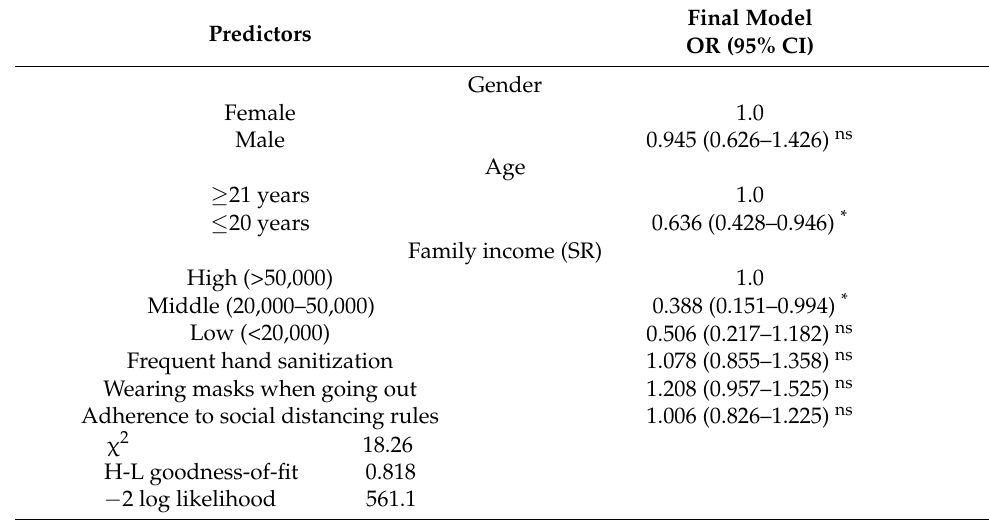
Table 3. Logistic regression analysis results for the predictors of depressive symptomatology.